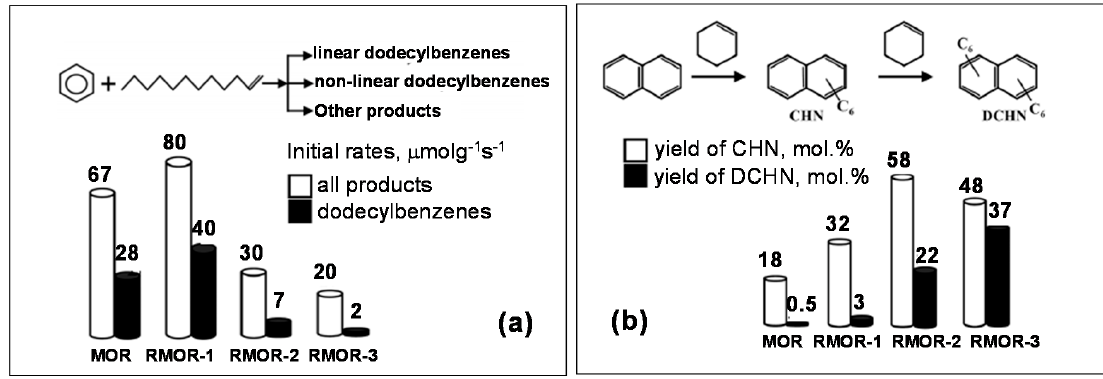
Figure 11. Catalytic performance of parent mordenite (MOR) and recrystallized MOR/MCM-41 composites (RMOR) in ( a ) alkylation of benzene with dodec-1-ene and ( b ) alkylation of naphthalene with cyclohexene. Adapted with permission from [28]. Copyright Royal Society of Chemistry, 2013.